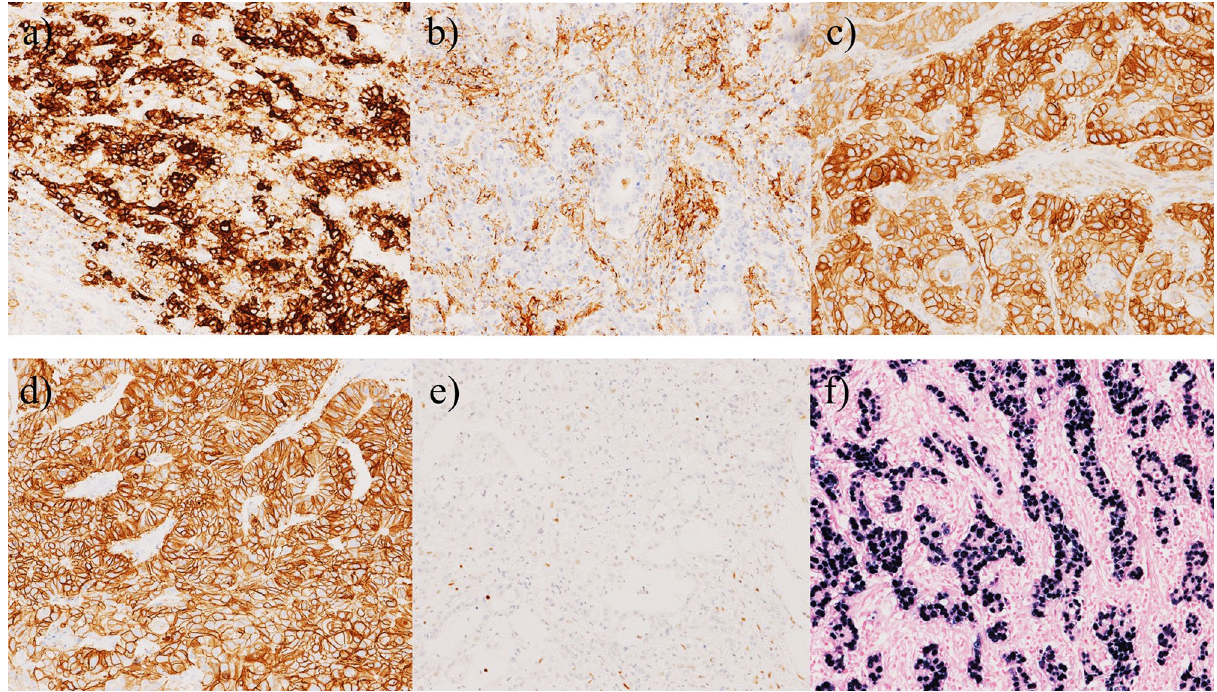
Figure 3. Representative images of samples subjected to immunohistochemical and in situ hybridisation analyses. ( a ) Programmed death ligand 1 (PD-L1)-positive (IHC score 3+) tumour cells; ( b ) PD-L1-positive (IHC score 3+) tumour-infiltrating cells; ( c ) epidermal growth factor receptor (EGFR) positive (IHC score 3+); ( d ) human epidermal growth factor receptor 2 (HER2) positive (IHC score 3+); ( e ) mutL homolog 1 (MLH1) loss; ( f ) Epstein–Barr virus (EBV)-encoded RNA